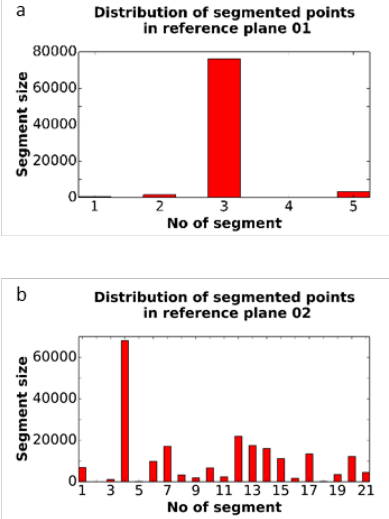
Figure 7. Bar plot segment number and number points per segmented plane. Shown are reference plane 01 (a) and 02